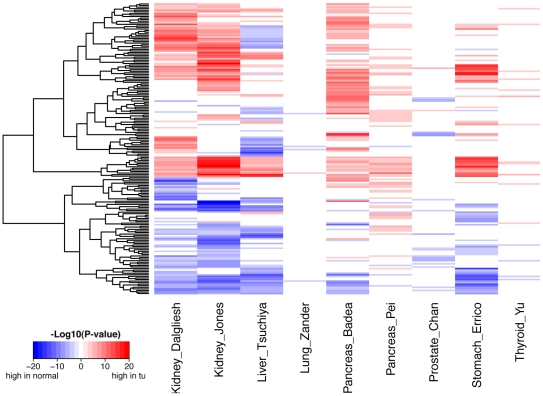
Pathways with differential activities between tumor samples and the corresponding normal tissues.The activity difference of a pathway in tumor and normal tissues was examined by the t−test and −log10(P−value) was color coded. Red indicates higher activity in tumors, and blue indicates higher activity in normal tissues. The results for 9 tumor/normal data sets are shown, representing 7 different cancer types.